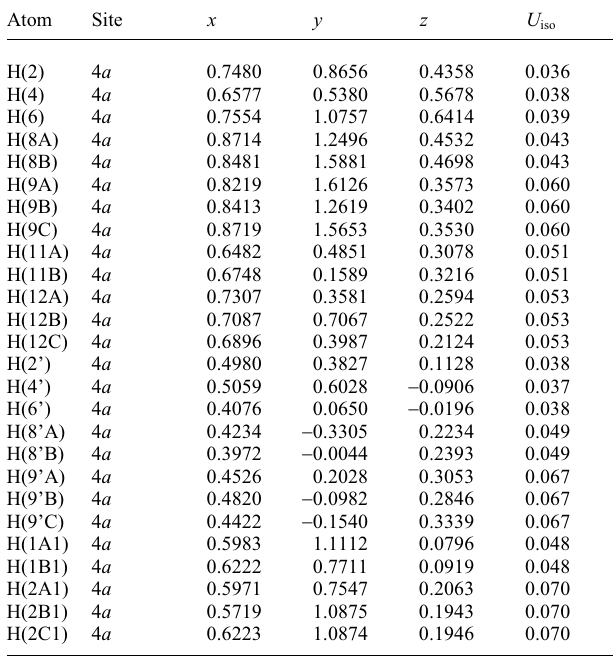
Table 1. Data collection and handling. Table 2. Atomic coordinates and displacement parameters (in Å 2 )